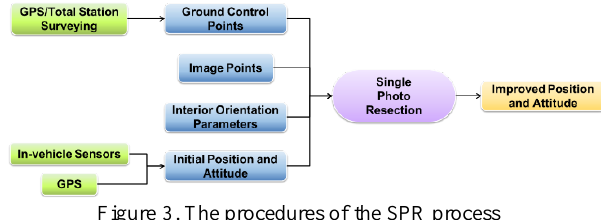
Figure 3. The procedures of the SPR process